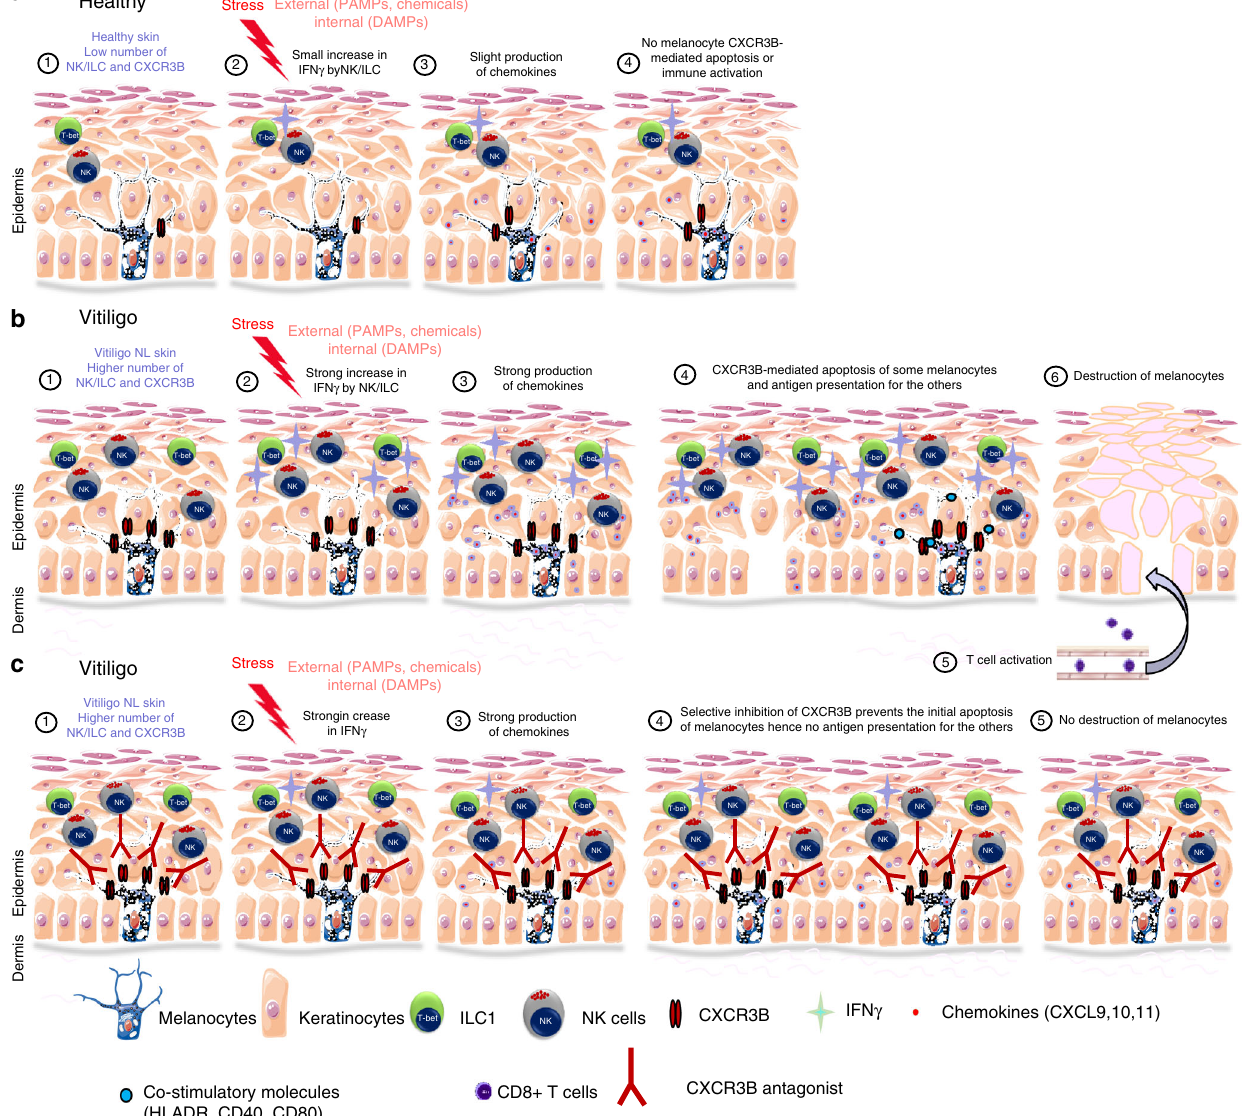
Fig. 6 Initial steps in the anti-melanocytic immune activation in vitiligo. a Schematic representation of normal skin. A low number of NK and ILC1 cells are present in the skin. External stress on the skin induces only a small increase in IFN γ by NK/ILC which is not suf fi cient to initiate their chemokines production, hence not initiating melanocyte apoptosis or immune activation. b Schematic representation of vitiligo skin. The basal number of NK and ILC1 cells is increased. Damage-associated molecular pattern (DAMP) molecules of genetically predisposed melanocytes can activate ILC1 and NK (1). Alternatively, ILC1 and NK can be also activated by external stress and pathogen-associated molecular pattern molecules (PAMP) (2). These NK and ILC cells are more sensitive to stress compared to healthy individuals and in response, they produce large amount of IFN γ (2) that induces the secretion of chemokines by keratinocytes and to a lesser extent by melanocytes (3). These chemokines (mostly CXCL10), bind chemokine receptor CXCR3B at the surface of melanocytes and induces their initial apoptosis and release of melanocytic antigens. The remaining melanocytes stimulated by IFN γ express co- stimulatory (CD40, CD80, HLA-DR) and adhesion (ICAM-1) molecules and start presenting their own antigens to the naive T cells attracted by the chemokines (5), thus initiating the initial steps involved in anti-melanocytic immunity in the skin (6). c Schematic representation of vitiligo skin treated with a selective inhibition of the B isoform of CXCR3. DAMPs and PAMPs induce a strong production of IFN γ by NK and ILC1 cells followed by a potent production of chemokines. However, the selective inhibition of CXCR3B prevents the initial melanocytic apoptosis and subsequent presentation